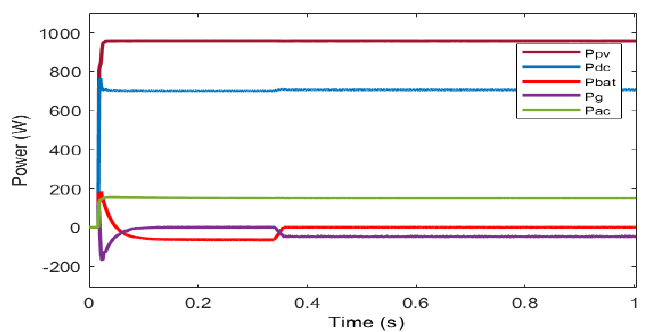
Figure 17. PV, DC load, AC load, grid, and battery power in SPM.